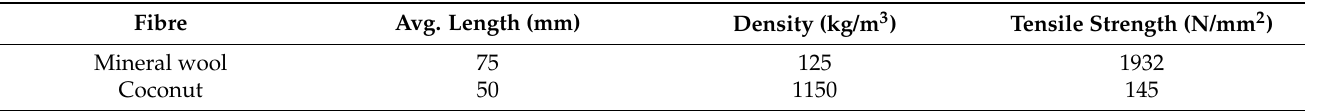
Table 1. Natural fibre properties.